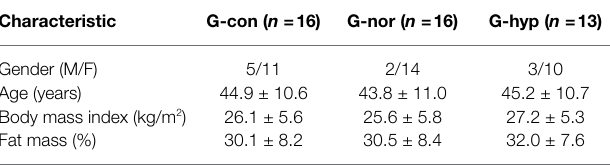
TABLE 1 | Participant gender, age, and body composition (mean ± SD).